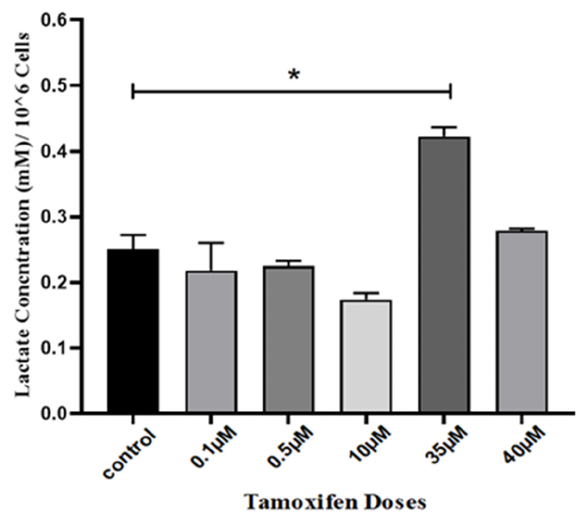
Figure 5. Calculated concentration by CE-C4D of produced lactate from MCF-7 cell supernatant media normalized with cell density after treatment with tamoxifen in gradual increased doses. Statistical significance was calculated by one-way ANOVA followed by Tukey post hoc test in GraphPad prism 8.0 software, considering the statistical significance as follows: * significant at P ≤ 0.05; results were expressed as mean ± SD ( n = 3 runs for each sample).